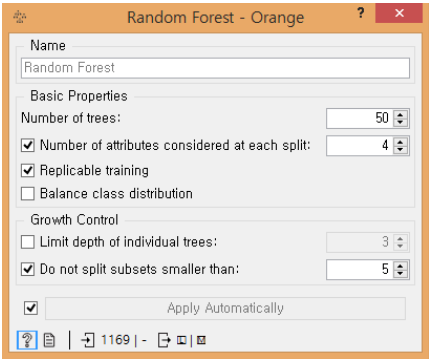
Figure 9. Parameters of the proposed random forest model [79].